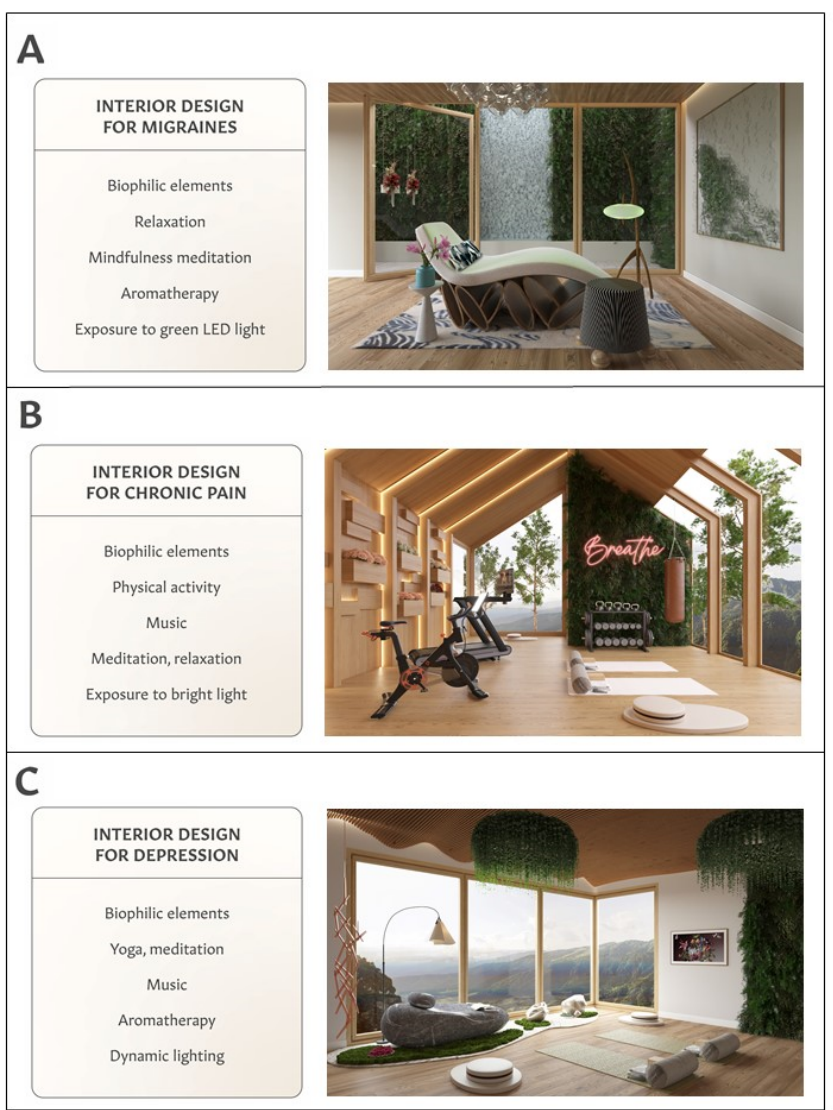
Figure 2. Designing therapeutic interior environments for people with migraines ( A ), chronic pain ( B ) and depression ( C ). Disease-specific interior designs are based on studies summarized in Tables 1–3.